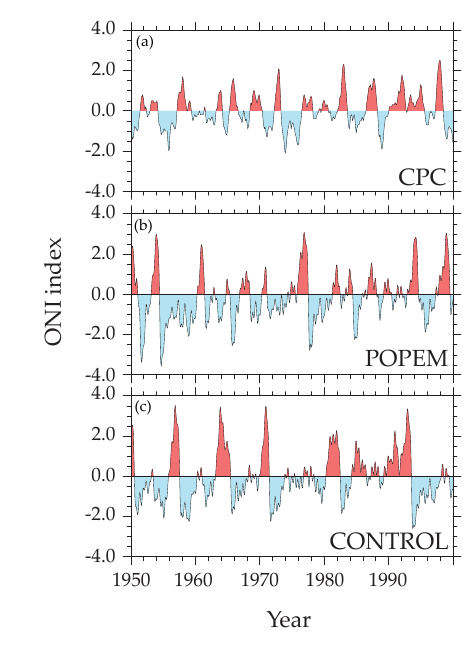
Figure 14. Comparison of the Oceanic El Niño Index (ONI) for CPC (a) , POPEM (b) , and CONTROL (c) cases. El Niño and La Niña are defined according to Kousky and Higgins (2007): 3-month running mean with anomalies greater than + 0 . 5 ◦ C (or − 0 . 5 ◦ C) for at least 5 consecutive months in the NIÑO3.4 region. The base period for computing SST departures is